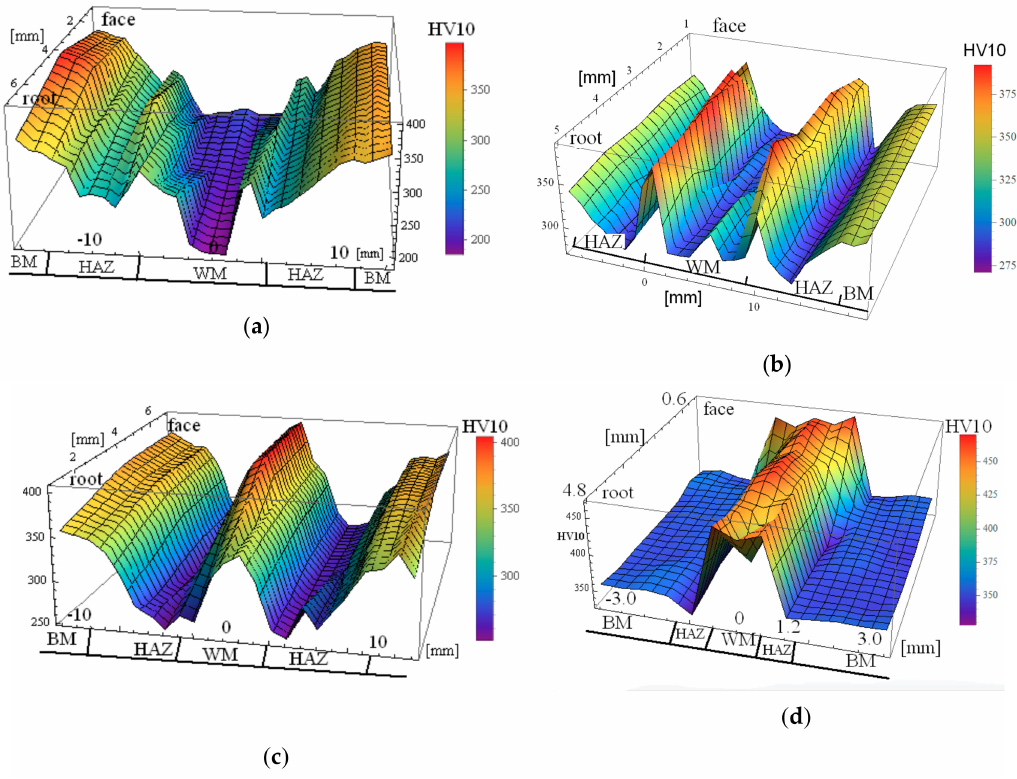
Figure 3. Hardness distribution of the analyzed welded joints: ( a ) Q 1; ( b ) Q 2; ( c ) Q 3; ( d ) Q